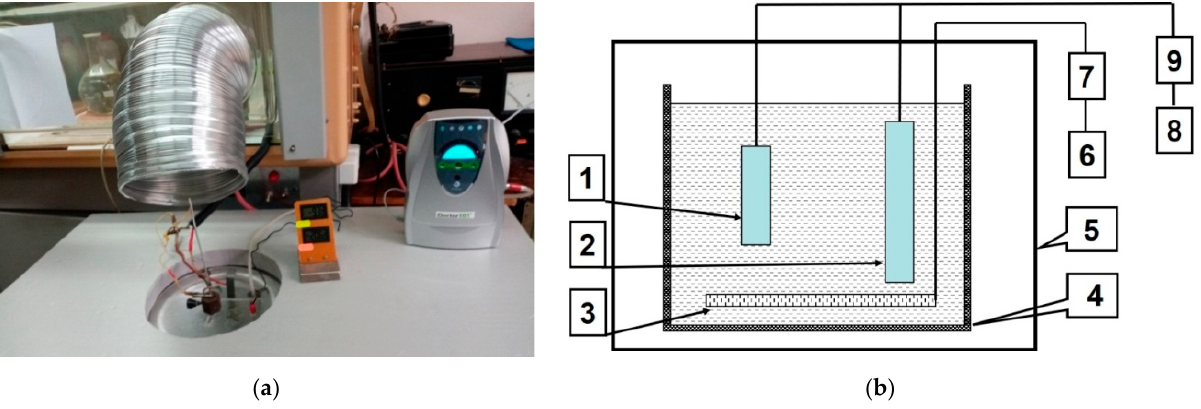
Figure 1. ( a ) General view of the installation for the synthesis of hard anodized layers on the surface of aluminum alloy specimens; ( b ) and its schematic representation: 1—specimen for anodizing; 2— electrode; 3—bubbler; 4—container with electrolyte (20% aqueous solution of H 2 SO 4 ); 5—chamber for stabilizing the temperature regime of the anodizing process in the range of − 4–0 °C; 6— compressor; 7—block for adjusting the performance of the bubbler and compressor; 8—power supply for maintaining the current density of 5 A/dm 2 between the specimen and the electrode; 9— block for adjusting and controlling the power of the power source.